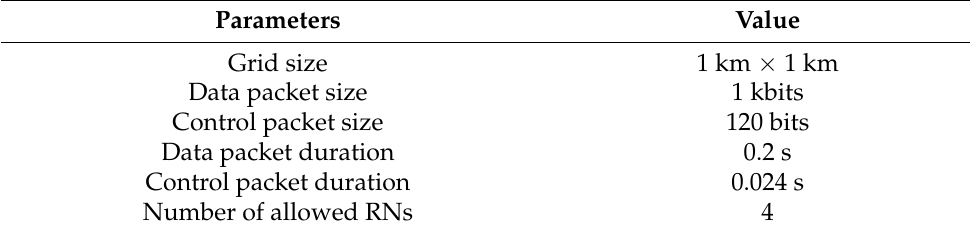
Figure 6. UWA Layout. Table 1. System